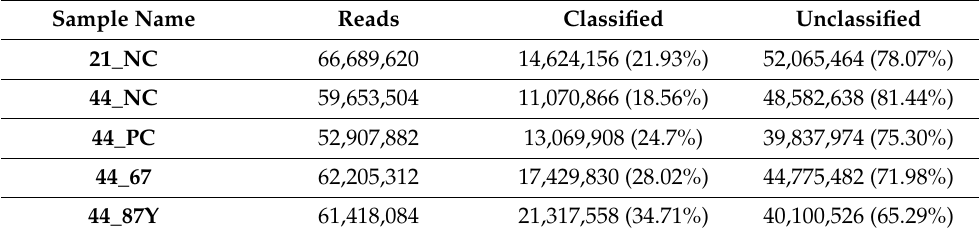
Table 6. Taxonomic profiling metrics.